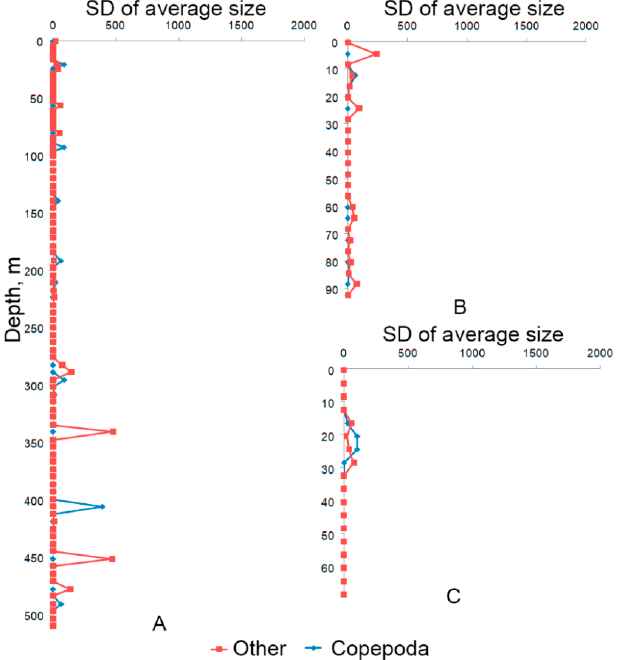
Figure 12. Standard deviation (SD) of particle sizes by stations: ( A ) Station no. 6 with submersion up to 500 m and geographical coordinates 44°31.2398 ′ N 37°54.3828 ′ E; ( B ) Station no. 5 with submersion up to 100 m and coordinates 44°32.0743 ′ N 37°55.3762 ′ E; ( C ) Station no. 4 with submersion up to 70 m and coordinates 44°32.1922 ′ N 37°56.0360 ′ E.